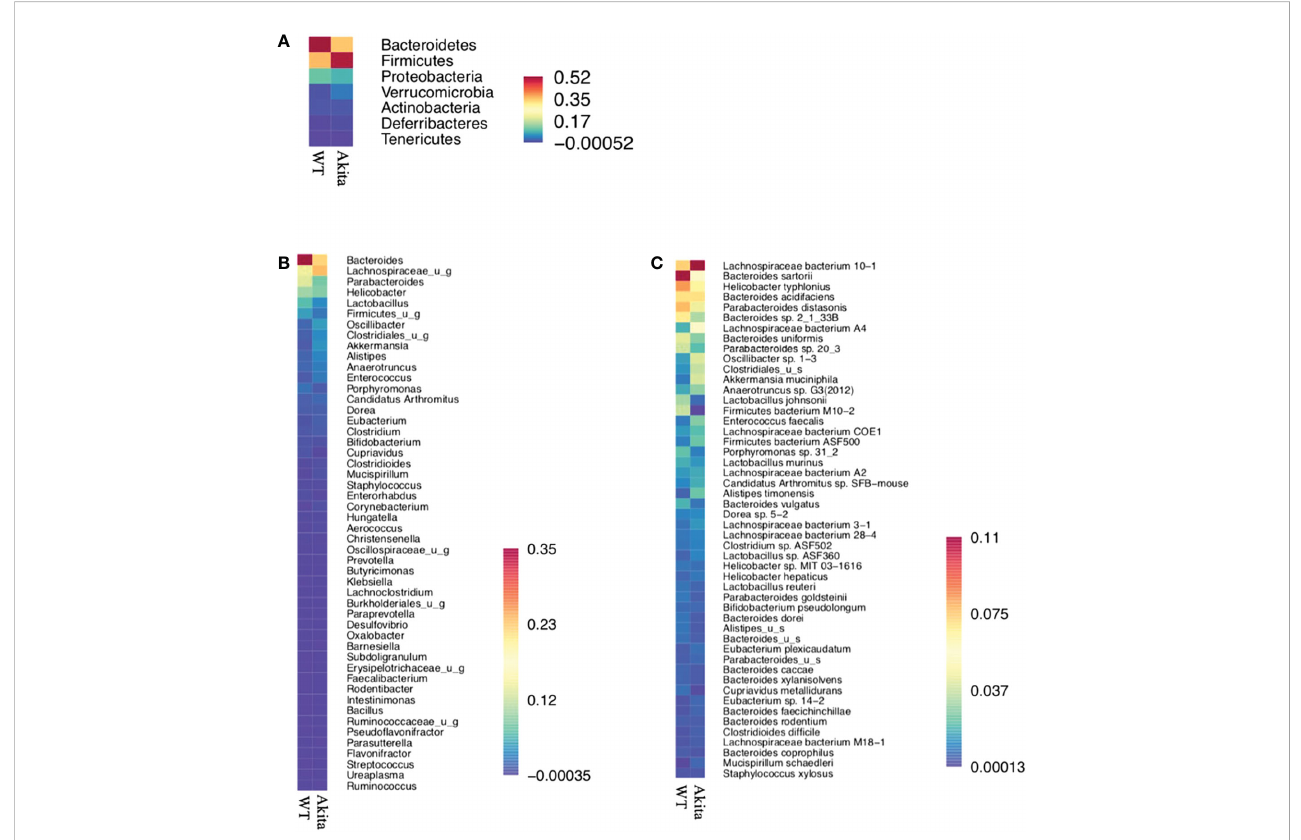
FIGURE 7 Heat maps for relative abundance of bacteria present in the intestinal microbiome of WT and Akita mice at the phylum, species, and genus level. (A) Heat map of bacteria present in intestinal microbiome of WT and Akita mice generated at the phylum level based on mean relative abundance. (B) Heat map of bacteria present in the intestinal microbiome of WT and Akita mice generated at the genus level based on mean relative abundance. (C) Heat map of bacteria present in the intestinal microbiome of WT and Akita mice generated at the species level based on mean relative abundance. Values of relative abundance are presented with corresponding colors as shown in the legend for B to D ( n = 5 in WT and